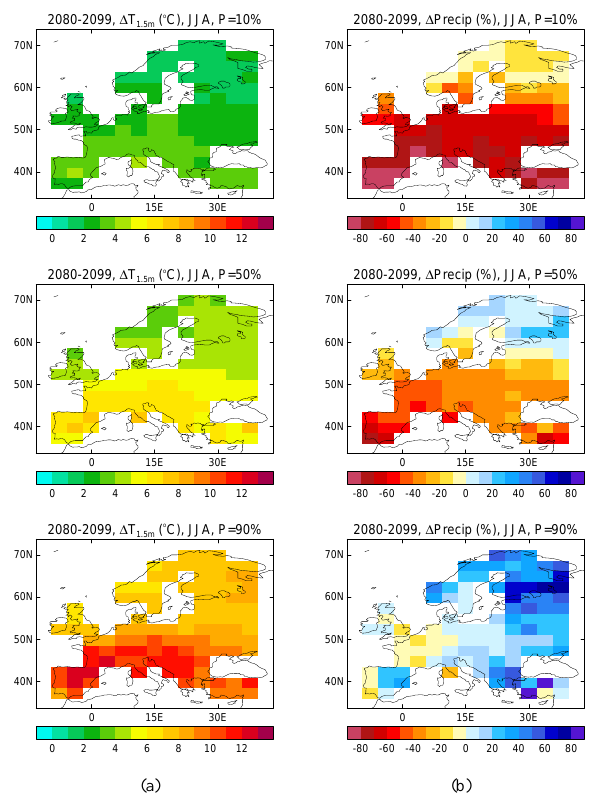
Fig. 10. Maps of the 10%, 50% (median) and 90% percentiles of the PDF for: (a) European surface temperature change; (b) Euro- pean percentage precipitation change, for the summer season for the period 2080–2099 relative to the 1961–1990 baseline